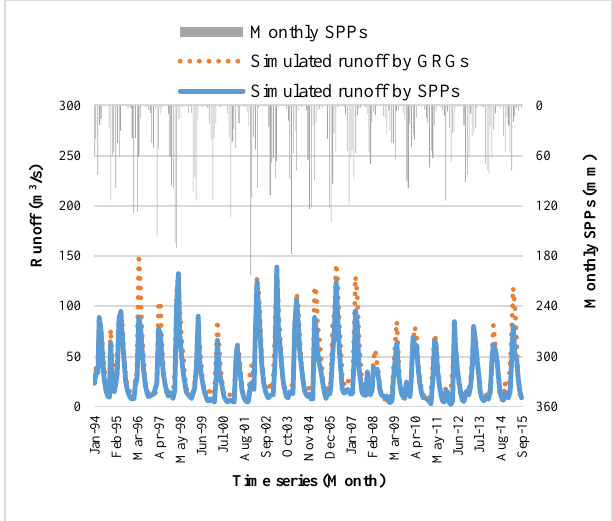
Figure 5. Time series of the best runoff simulated by the SWAT model using GRGs and SPPs datasets, and PERSIANN-CDR total monthly precipitation over the period of